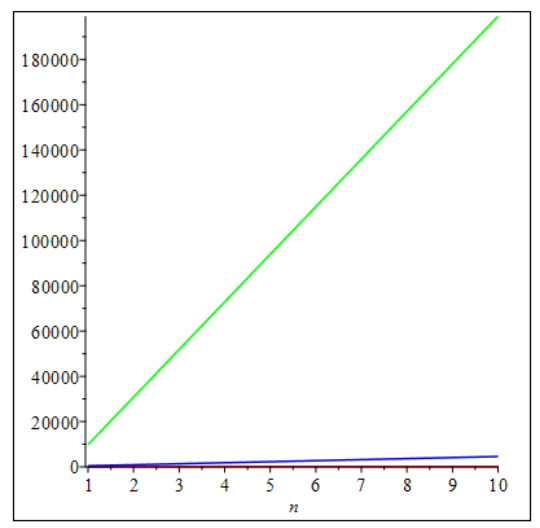
Figure 7. The graphical representation of the first, second, and third Zagreb indices of FCC ( n ) . The red, blue, and green colors represent ReZG 1 ( G ) , ReZG 2 ( G ) , and ReZG 3 ( G ) , respectively.